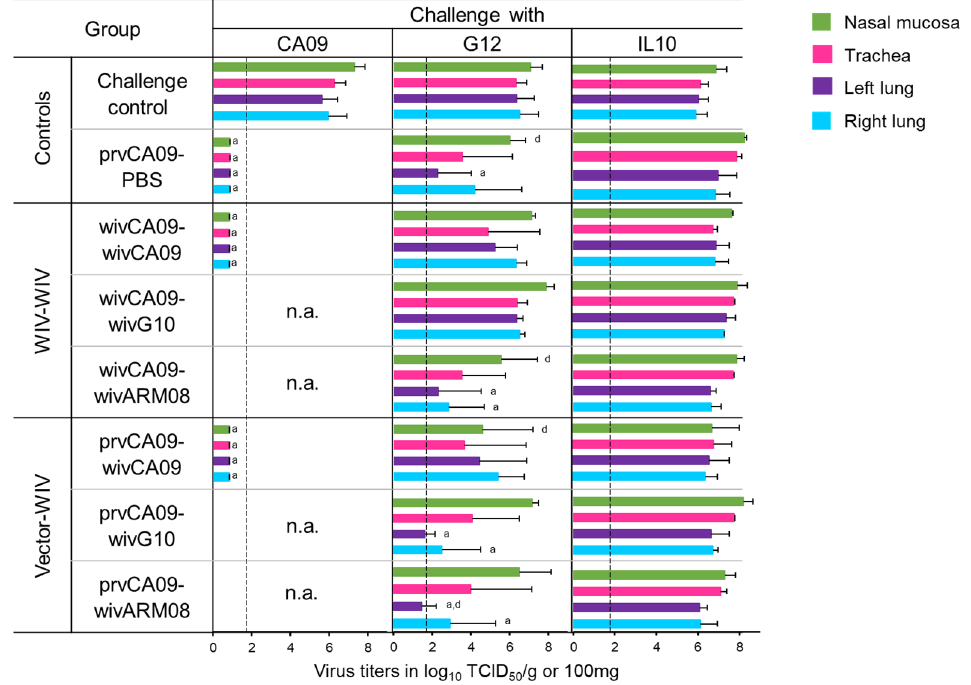
Figure 4. Virus titers in the respiratory tract three days post-challenge with CA09, G12, and IL10. The bars represent mean virus titers and their standard deviation. Each color represents a different tissue. Dotted lines indicate the detection limit (1.7). Virus titers in nasal swabs are expressed in log10 TCID50/100 mg nasal secrete, virus titers in the trachea and lung are expressed in log10 TCID50/g tissue. Letters indicate significant differences to challenge control (a), prvCA09–PBS (b), wivCA09–wivCA09 (c), wivCA09–wivG10 (d), wivCA09–wivARM08 (e), prvCA09–wivG10 (f), prvCA09–wivARM08 (g) in the Kruskall–Wallis test ( p ≤ 0.05). See Figure 1 for full names of virus strains.